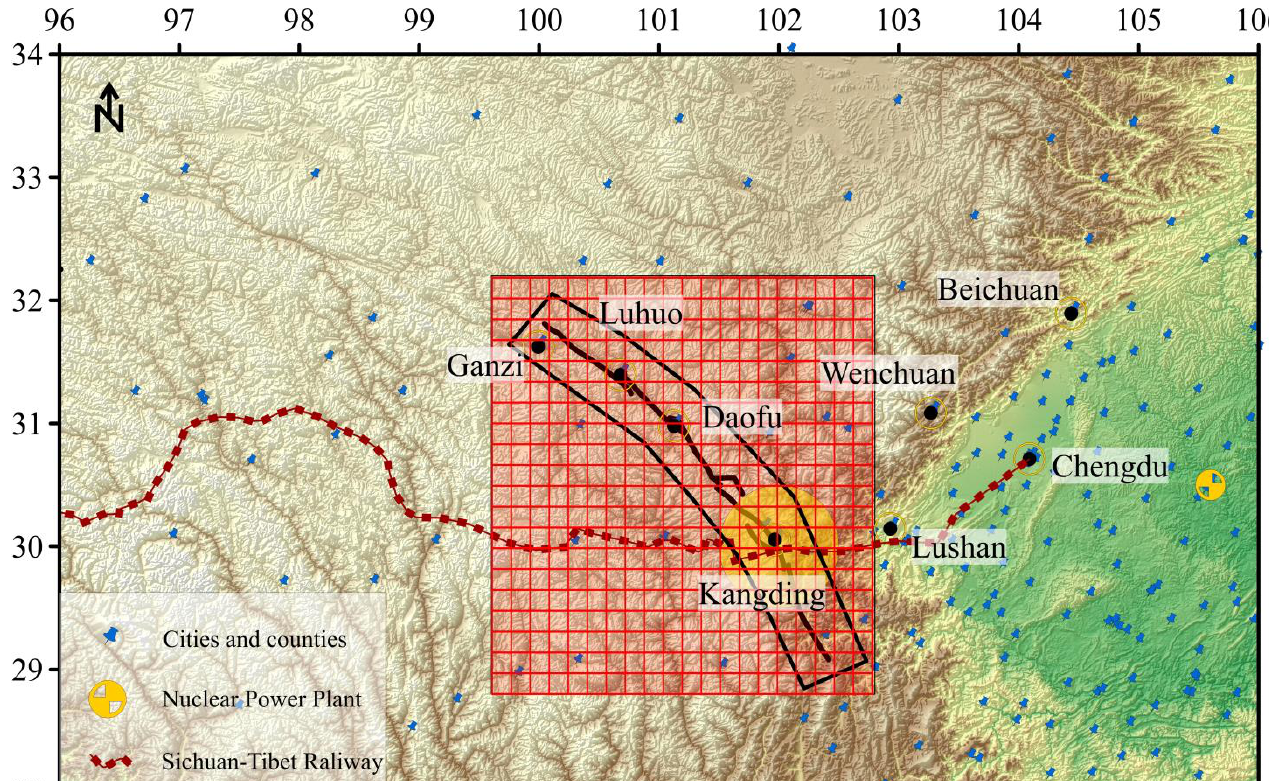
Figure 1. The study area of EEW2.0. The red grid, covering 99.6°~102.8° (E) and 28.8°~32.2° (N), shows the area where the scenario earthquakes are considered. The irregular black polygon enclosing part of the red cells stands for the Xianshuihe Fault Zone (XSH). The black lines stand for segments of XSH [34]. It can be clearly seen that the red grid covers the four vertices of the irregular polygons surrounding XSH. The yellow circle stands for the seismogenic node prone to M ≥ 8.2 earthquakes [35]. The blue pushpins stand for the residential areas, and Chengdu, Lushan, Kangding, Wenchuan, Beichuan, Daofu, Luhuo, and Ganzi are indicated by black dots. The approximate location of the planned Sanba Nuclear Power Plant is marked by a pierced yellow circle. The approximate location of the Sichuan-Tibet railway is also displayed.